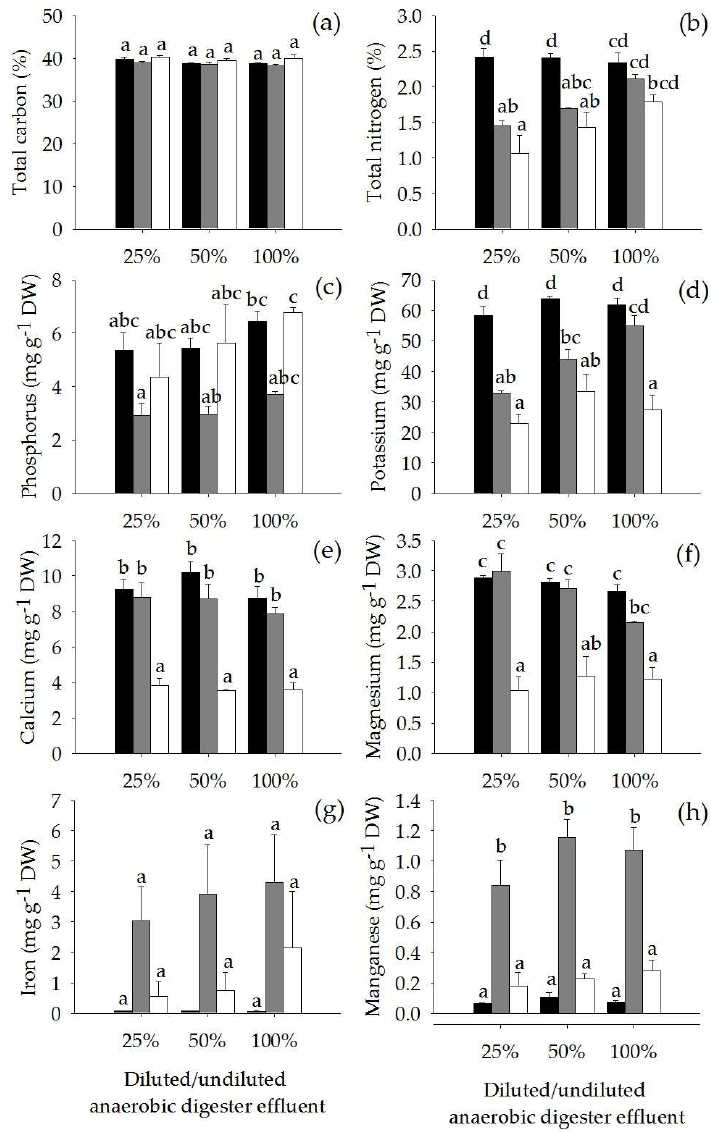
Figure 5. Concentrations of total carbon ( a ), total nitrogen ( b ), phosphorus ( c ), potassium ( d ), calcium ( e ), magnesium ( f ), iron ( g ) and manganese ( h ) (Mean ± SE) in leaves ( (cid:4) ), roots ( (cid:4) ) and rhizomes ( (cid:3) ) (Mean ± SE) of Acorus calamus grown on diluted anaerobic digester effluent (25% and 50%) and undiluted anaerobic digester effluent (100%) for 56 days. Different letters indicate significant differences among treatments.